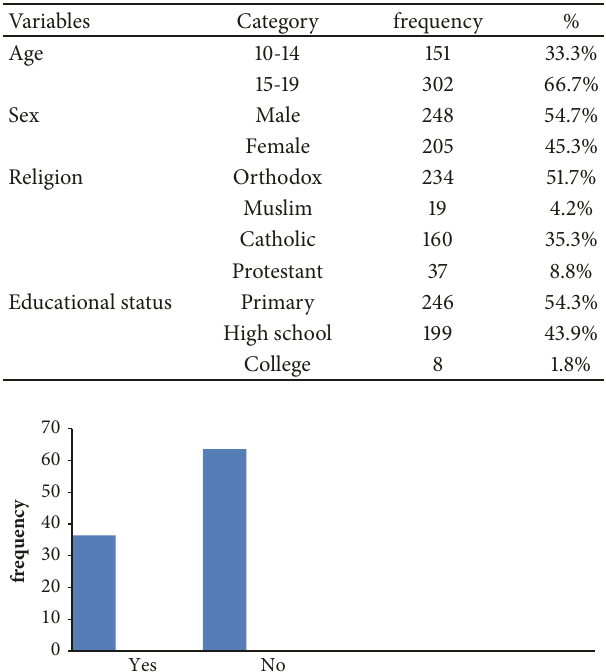
Table 1: Sociodemographic characteristicsof orphan adolescents in Addis Ababa, Ethiopia, Jul 2016 (N-453).